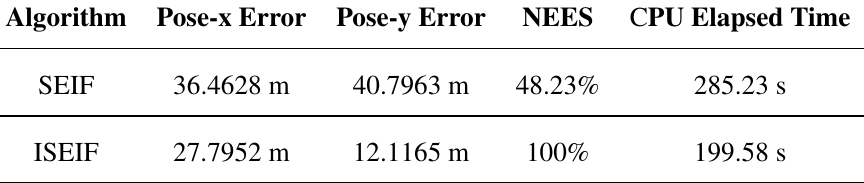
Table 5. Comparisons of performances of SEIF and ISEIF for the sea trial.